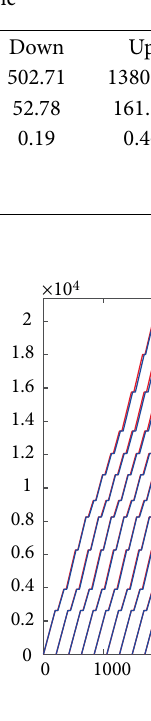
Figure 13: A comparison of the CUT (red lines) and the OEST (blue lines).